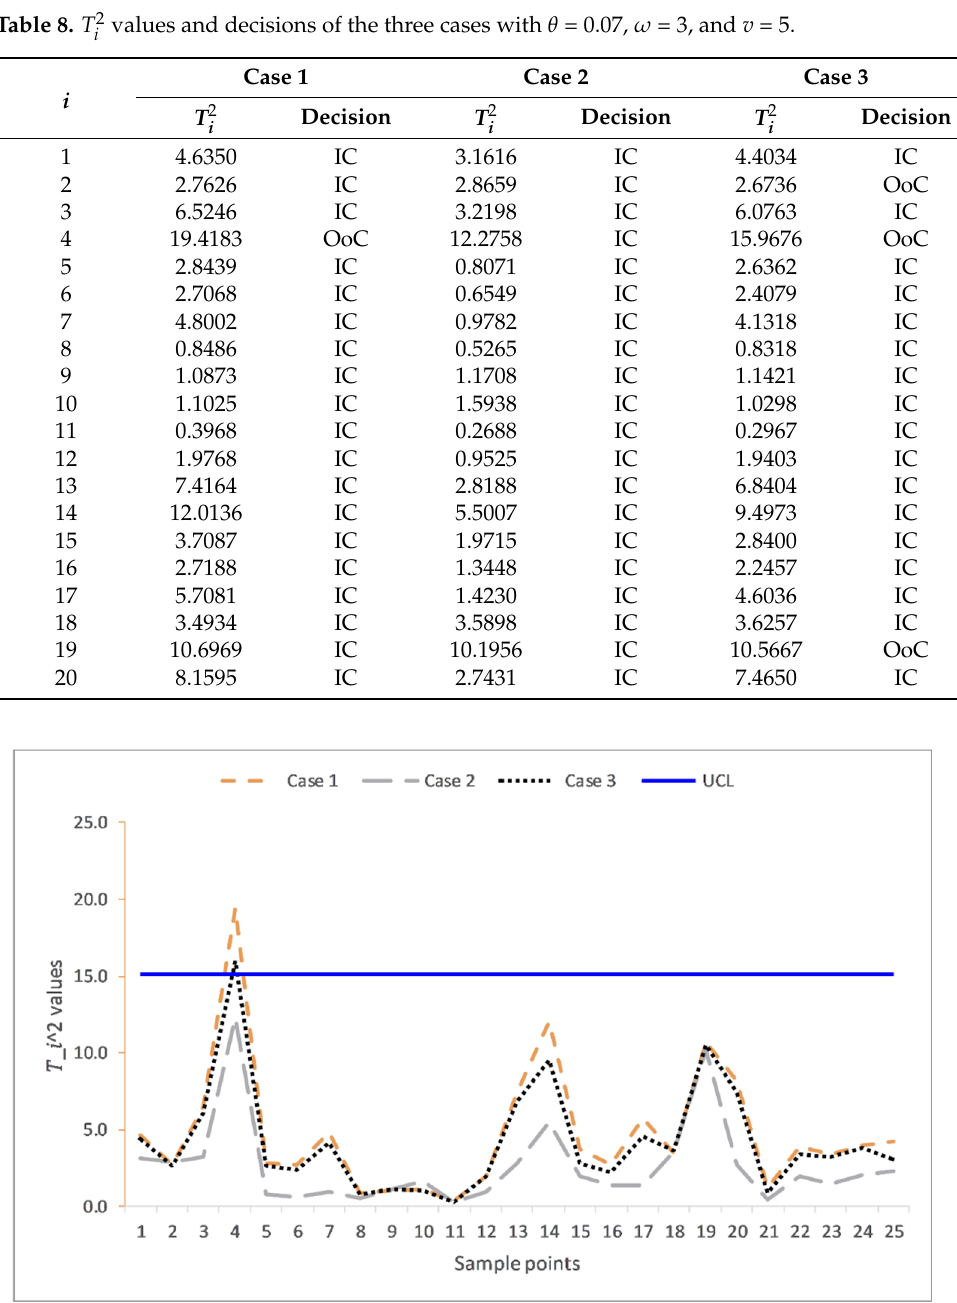
Figure 6. The multivariate Shewhart charts from real life data extracted from carbon fiber tubes.